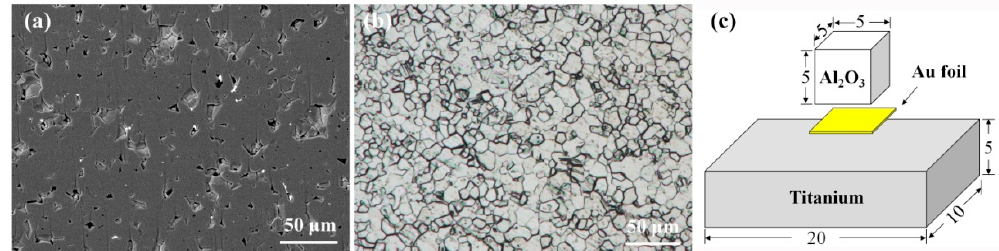
Figure 1. Microstructures of substrates and schematic diagram of brazing assembly. ( a ) BSE image of Al 2 O 3 ceramic, ( b ) metallographic figure of α -Ti alloy, and ( c ) brazing assembly (mm).